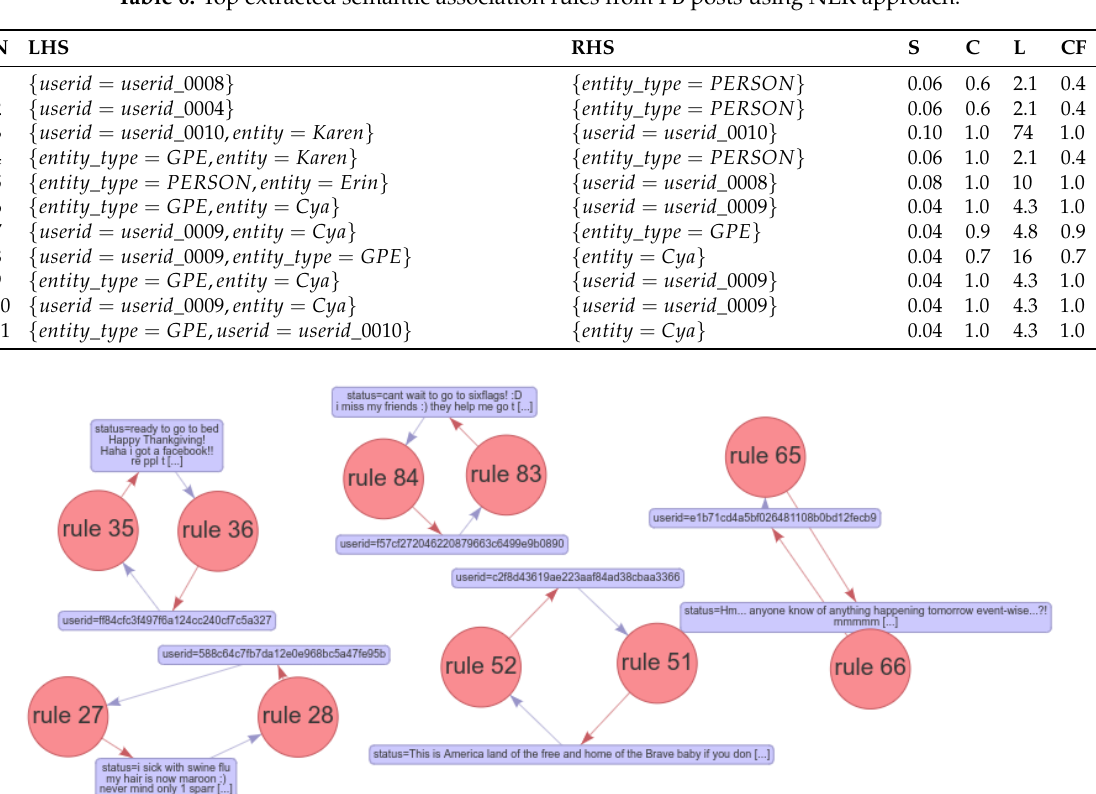
Table 6. Top extracted semantic association rules from FB posts using NER approach.